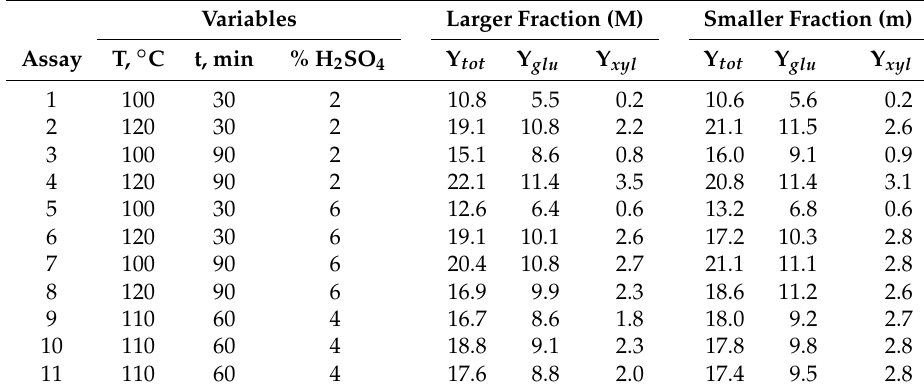
Table 3. Sugar yields,